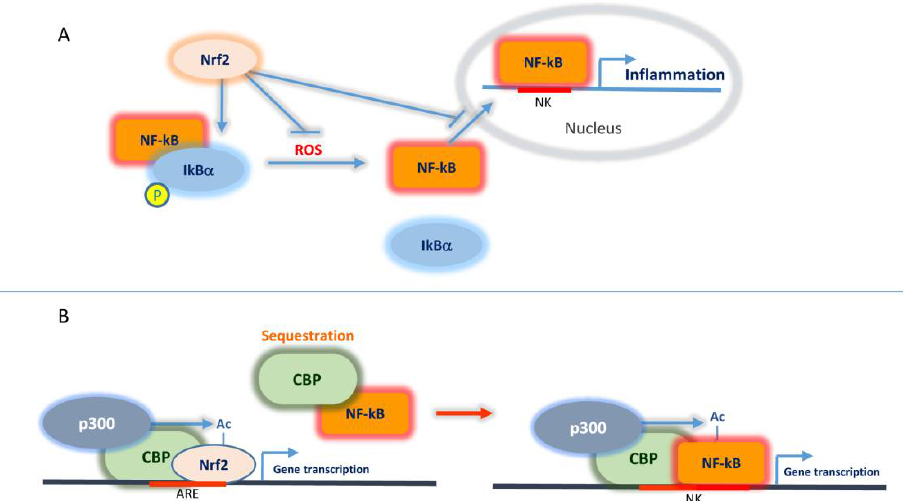
Figure 3. Mutual regulation between Nrf2 and NF- κ B. ( A ) Nrf2 inhibits NF- κ B at different levels: (i) it contributes to I κ B- α stabilization and consequent NF- κ B retention to the cytoplasm and subsequent degradation, (ii) it attenuates ROS levels thus affecting one major NF- κ B activating stimulus, (iii) it interferes with NF- κ B nuclear translocation. ( B ) Nrf2 interacts and cooperates with CBP/p300 at the nuclear level to promote gene transcription. NF- κ B can compete with Nrf2 for CBP binding thus sequestering the factor and recruiting it to specific NF- κ B response elements.